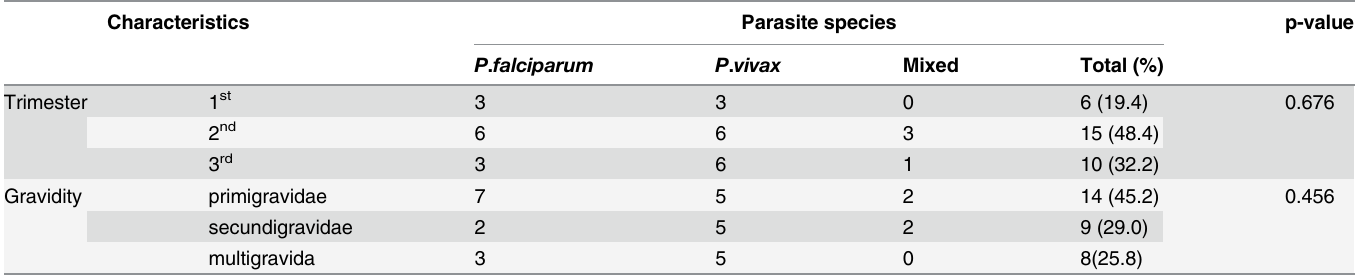
Table 2. Distribution of Plasmodium species with regard to trimester and gravidity among pregnant women in the rural surroundings of Arba- minch Town, South Ethiopia between April and June 2013.